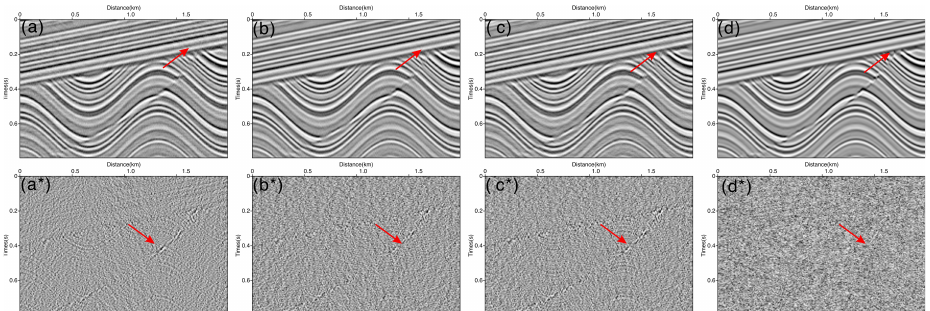
Figure 4. The comparison of AI-based denoised results with conventional method denoised results. ( a , a* ) RNA denoised result and its removed noise. ( b , b* ) APF denoised result and its removed noise. ( c , c* ) DnCNN denoised result and its removed noise. ( d , d* ) FACNN denoised result and its removed